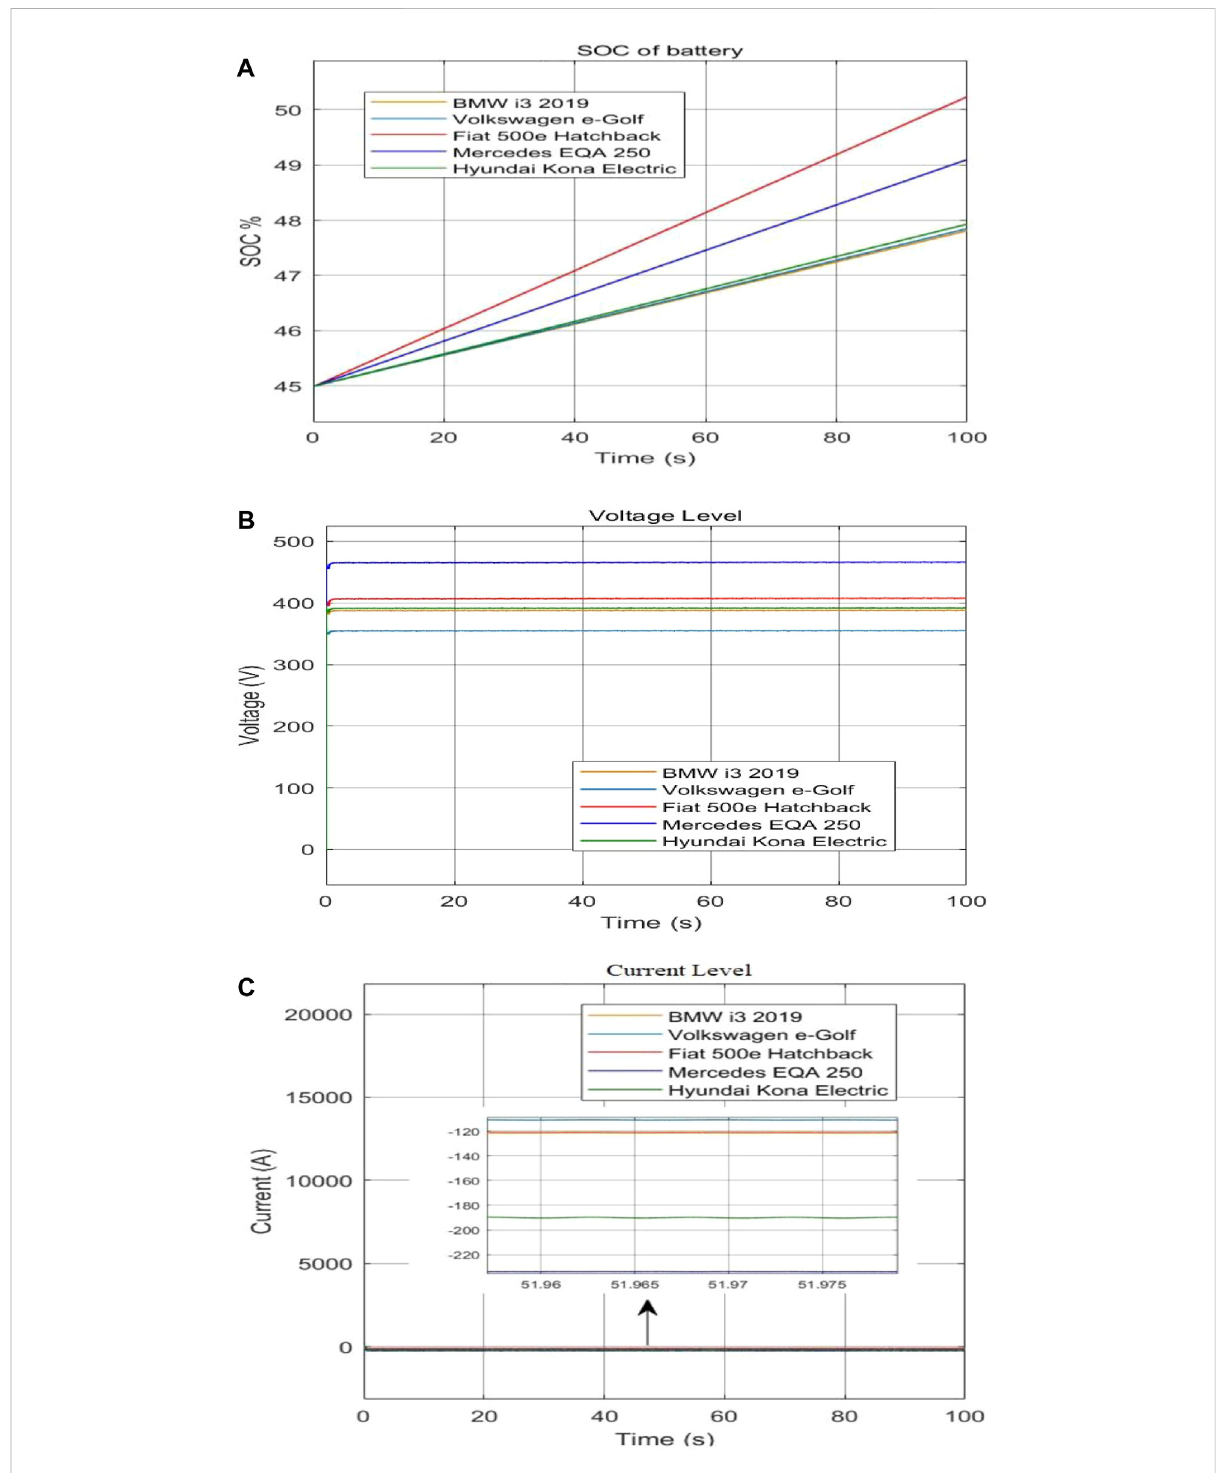
FIGURE 17 Charging for EV models. (A) SOC from 45% for 100 s, (B) voltage level, (C) current